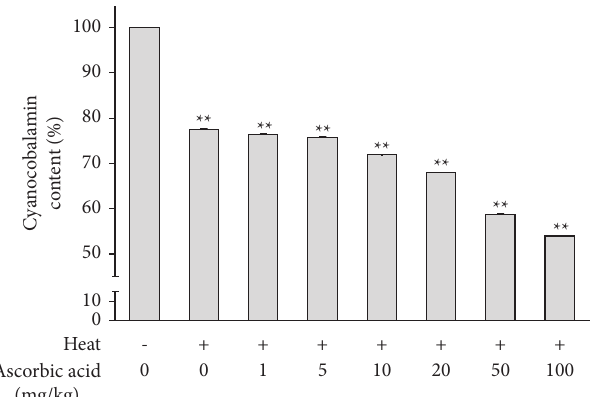
Figure 3: Effect of ascorbic acid on thermal stability of cyano- cobalamin. Ascorbic acid was treated in various concentrations (0, 1, 5, 10, 20, 50, and 100mg/kg) on heat condition (124 ° C, 10 min) in 100mg/kg cyanocobalamin standard solution. After heating, cy- anocobalamin in the samples was measured by HPLC analysis ( ∗ p < 0 . 05 and ∗∗ p < 0 . 01 versus the untreated sample; one-way ANOVA followed by Tukey’s post hoc test).